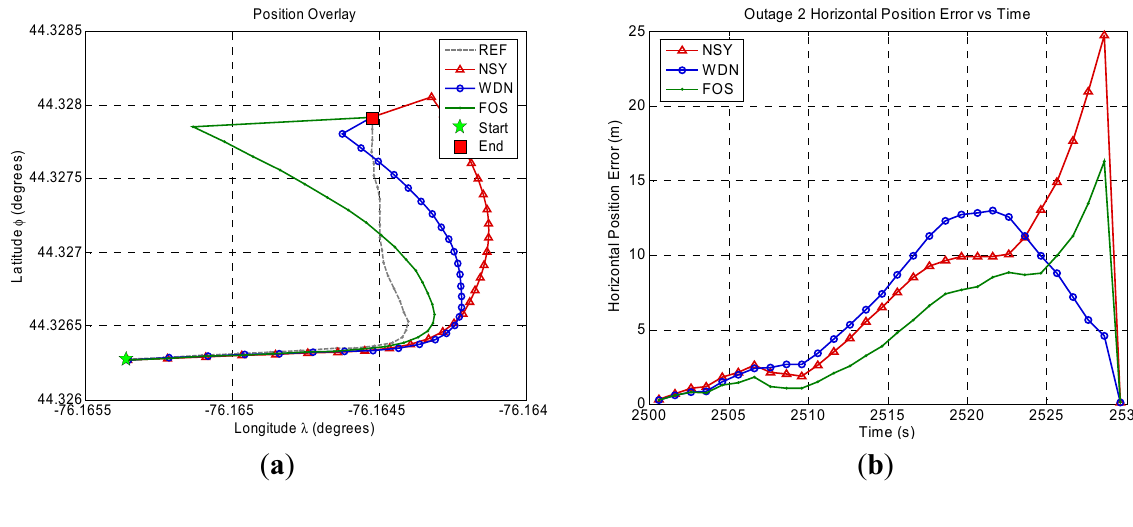
Figure 9. Land vehicle experiment position domain results for GPS outage 2. ( a ) Position domain plot. ( b ) Horizontal position error